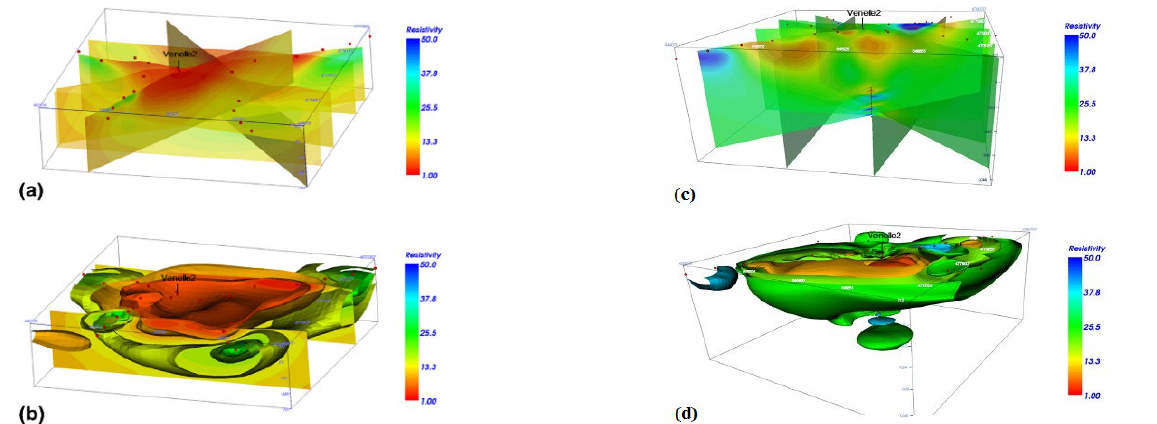
Figure 13. ( a ) 3D SH-DERT; ( b ) Resistivity isosurfaces obtained using only surface electrodes; ( c ) 3D full-data DERT; ( d ) Resistivity isosurfaces obtained using both surface and borehole electrodes. (Reprinted with permission from [44], Copyright (2022, Elsevier).